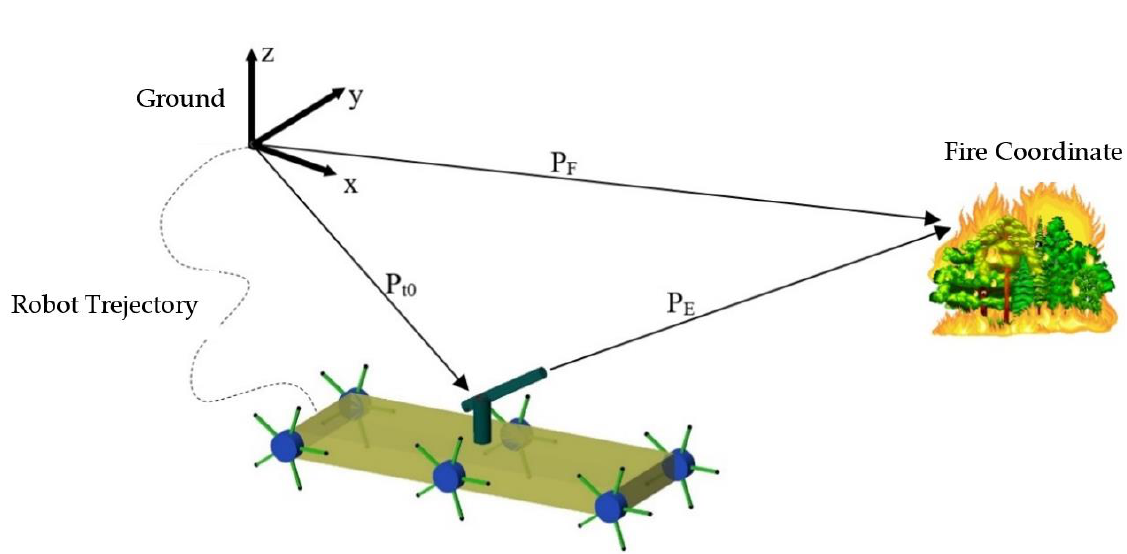
Figure 10. Barrel orientation vector.